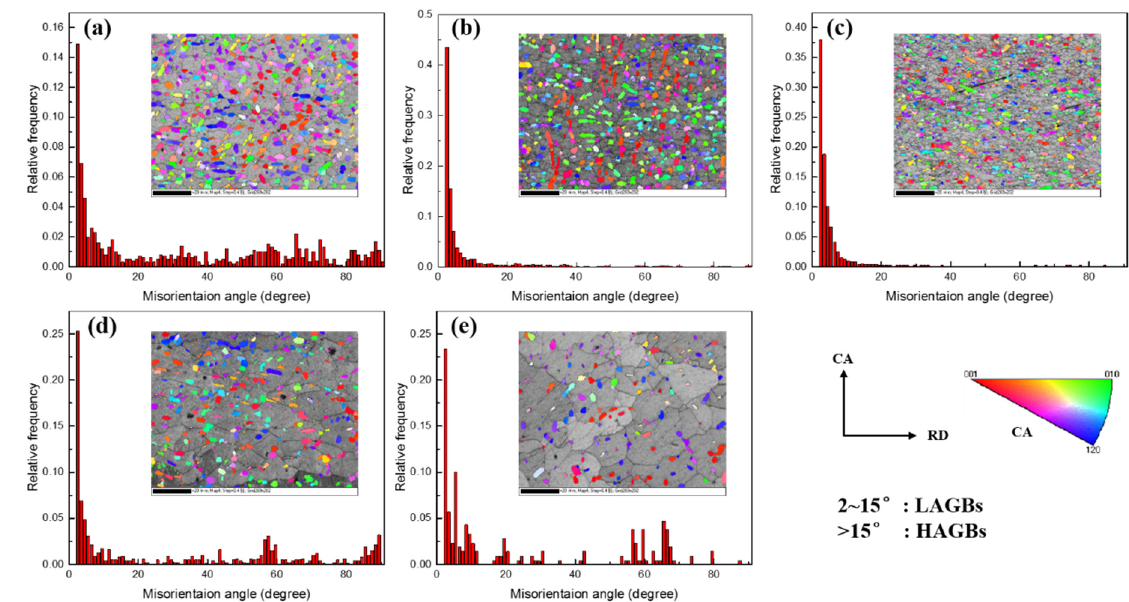
Figure 4. Distribution of grain boundary misorientation in the α phase for the deformed microstructure at different deformation conditions: ( a ) 740 °C/0.0001 s − 1 ; ( b ) 740 °C/0.01 s − 1 ; ( c ) 740 °C/1 s − 1 ; ( d ) 760 °C/0.0001 s − 1 ; ( e ) 780 °C/0.0001 s − 1 .